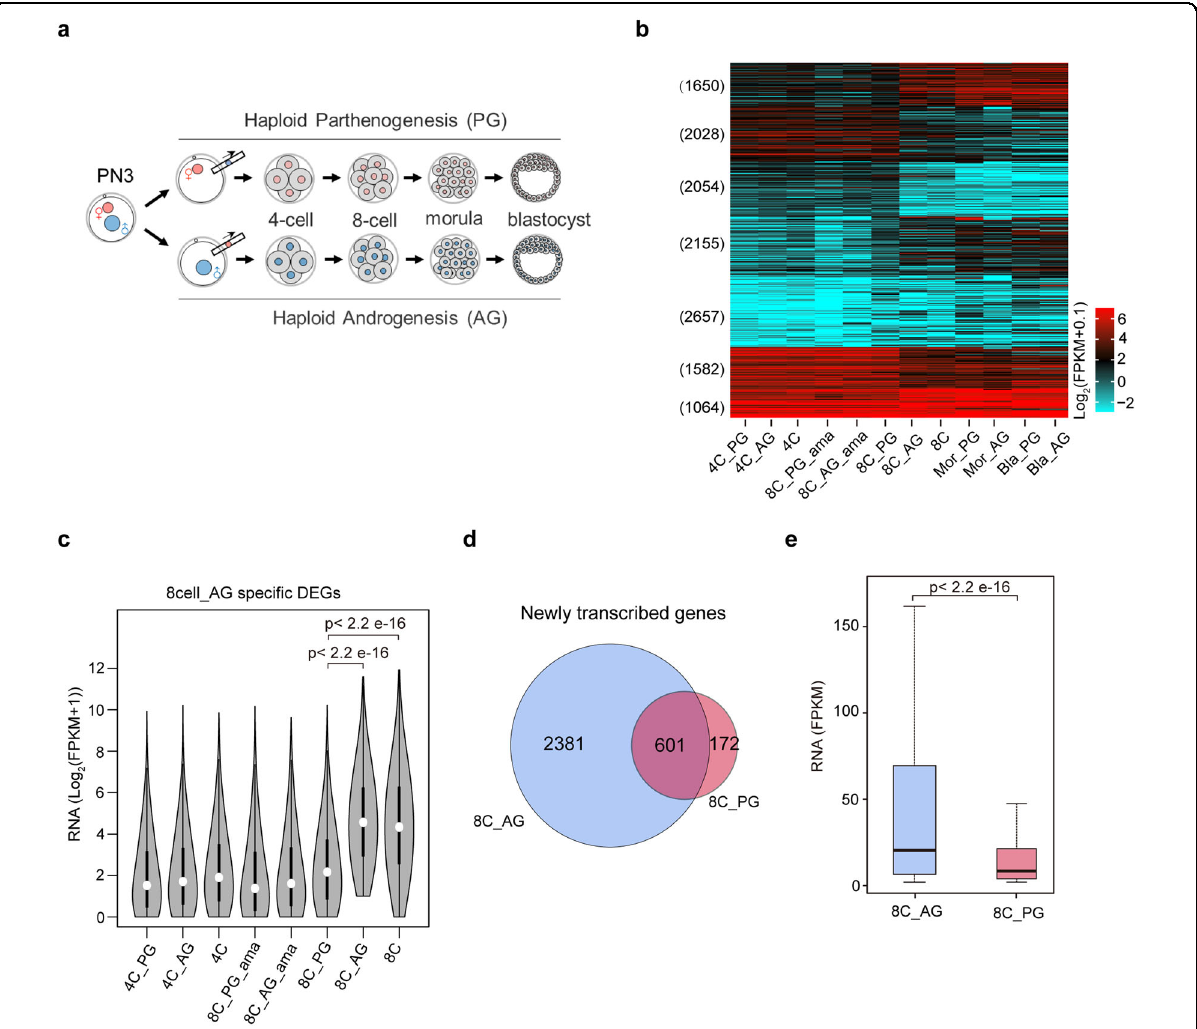
Fig. 1 Human ZGA is activated in AG embryos but delayed in PG embryos at the 8-cell stage. a Schematic of the generation of human haploid parthenogenetic (PG) and androgenetic (AG) embryos at early stages, which were used for RNA-seq. b Heatmap showing the expression levels of genes in human haploid embryos, α -amanitin (ama) treated haploid embryos and bi-parental embryos. The genes expressed at least one sample are clustered by k-means method. The gene number in each cluster is shown on the left. 4 C represents 4-cell embryos; 8 C represents 8-cell embryos; Mor represents morula; Bla represents blastocyst. c Violin plots comparing the expression levels of differential expressed genes (DEGs) with AG- speci fi c expression at the 8-cell stage in the indicated human embryos. Wilcoxon rank sum test was used. d Venn diagram comparing the newly transcribed genes between PG and AG 8-cell embryos. The genes, whose expression levels are signi fi cantly higher at 8-cell stage comparing to 4-cell stage, are de fi ned as newly transcribed genes. e Box plot comparing the expression levels of newly transcribed genes between AG and PG 8-cell embryos. Wilcoxon rank sum test was